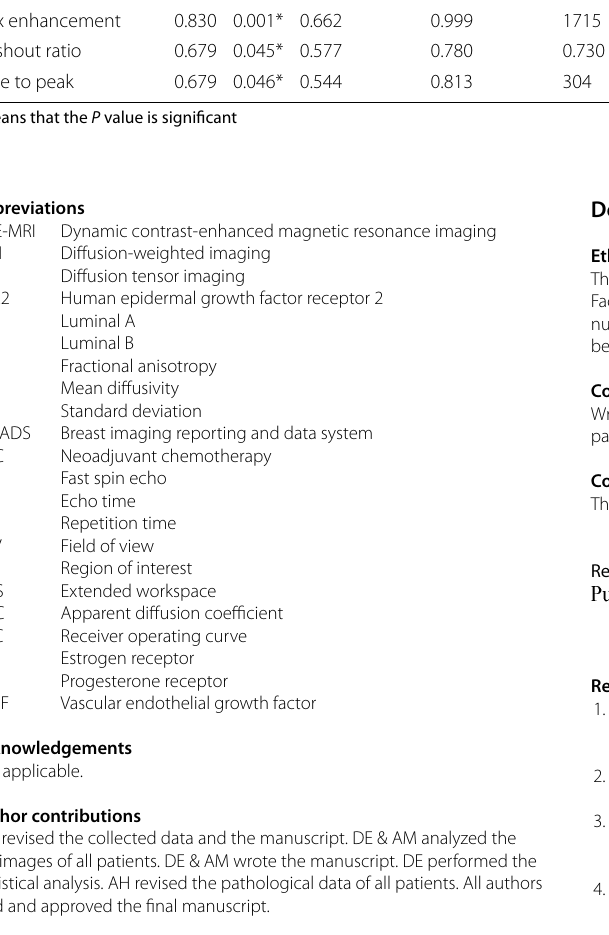
Table 3 Cut off values, sensitivity, specificity and accuracy of ADC, maximum enhancement, washout ratio & time to peak in differentiating between low and high Ki67 status Test Result Variable(s) Area